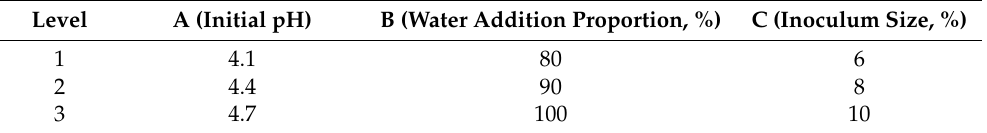
Table 2. The orthogonal experimental factors and levels.